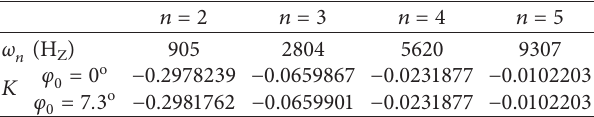
Table 1: The frequency and precession factor of the hemispherical